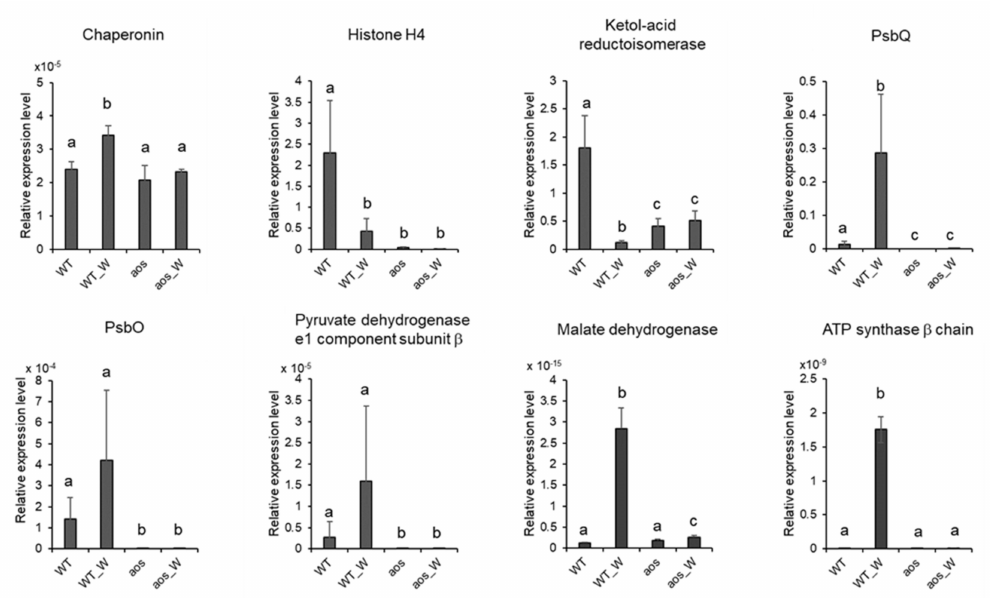
Figure 8. qRT-PCR analyses of genes encoding wound-accumulative proteins. The transcription levels of selected genes belonging to di ff erent groups were analyzed. The selected genes included the